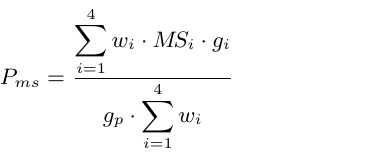
Table 2: Weights w and gains g for the investigated